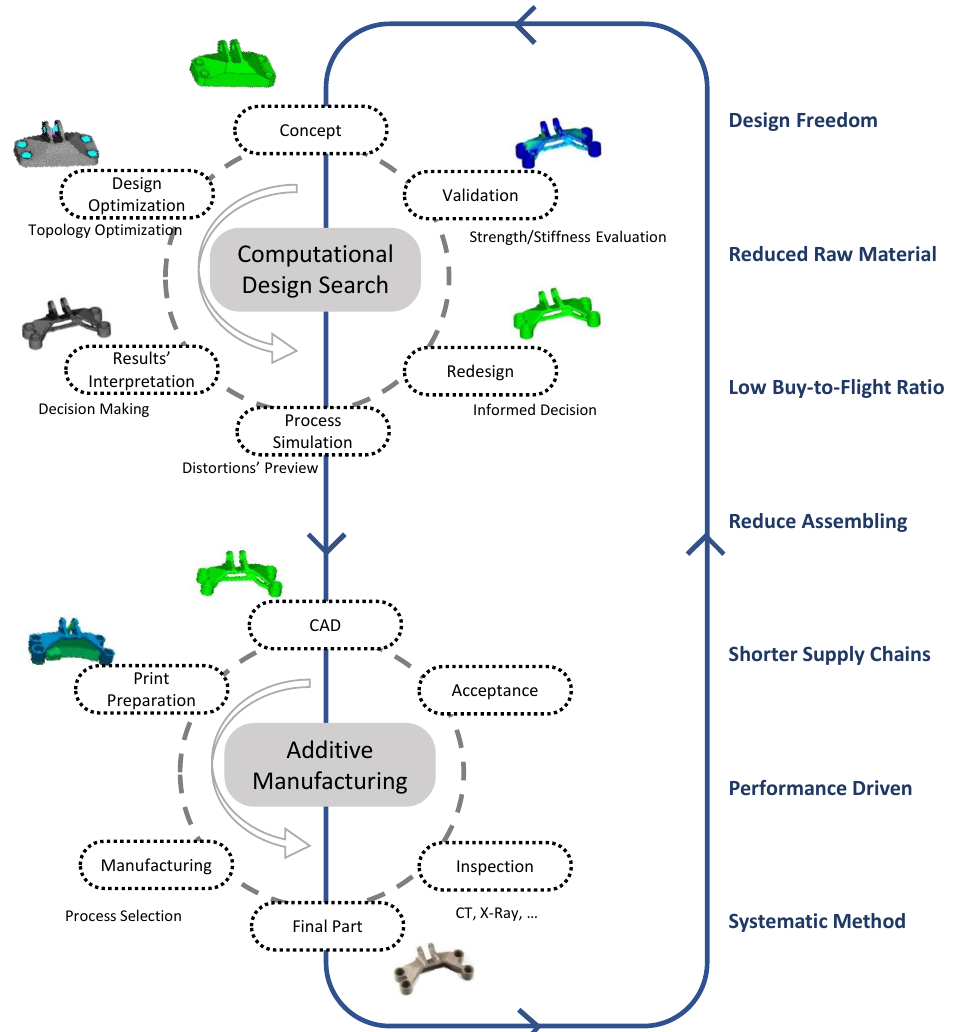
Figure 1. The interplay between additive manufacturing and topology optimization (bracket’s figures extracted from Komi